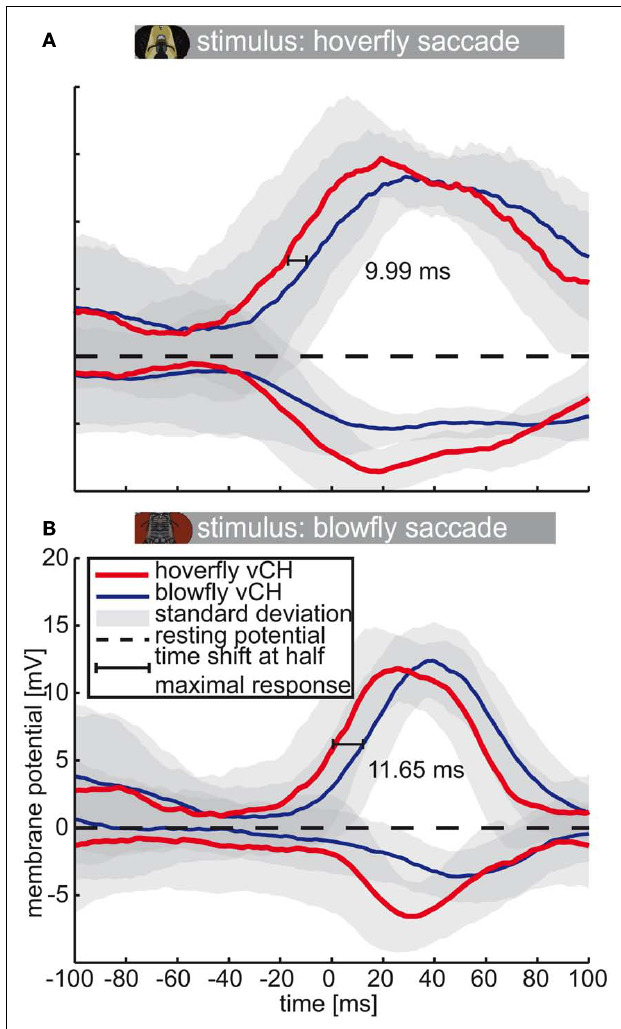
FIGURE 7 | Saccade-triggered vCH response. Mean response ( ± SD) of Eristalis and Calliphora vCH cells, respectively, in a 200-ms time window centered about the peak velocity of yaw saccades (0ms). Eristalis response ( N = 8, n = 3–11) is plotted in red and the Calliphora response ( N = 5, n = 3–23) is plotted in blue. Light green numbers and line denote the time shift between mean responses at half-maximal response. Resting potential is marked by the dashed black line. (A) Eristalis , (B) Calliphora saccades.